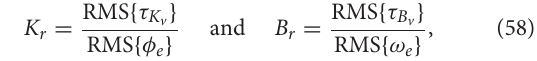
FIGURE 11 | Impedance control with inner H ∞ force control. Graphs show desired (blue) and measured (red) values for the platform torque, τ plat (top), and angular position of the ankle joint (bottom).